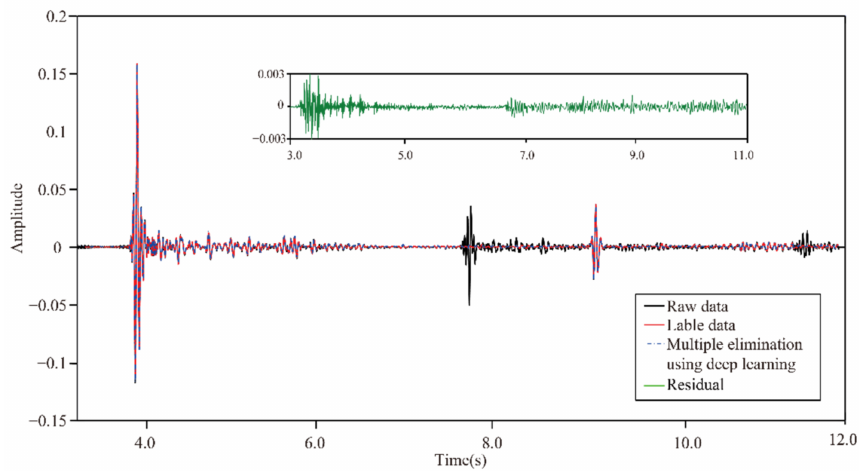
Figure 9. A comparison of 37th traces from Figure